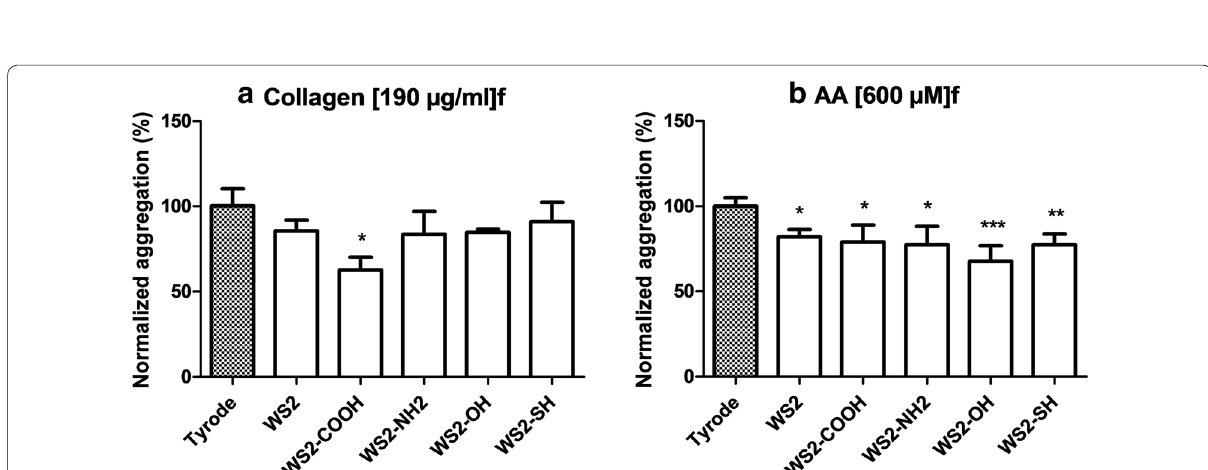
Fig. 3 Effect of functionalized INTs‑WS 2 at 100 µg/mL on platelet aggregation. Platelet aggregation was induced by ( a ) collagen or ( b ) AA. Tyrode was used as a negative control. Results are expressed as % of response (Mean